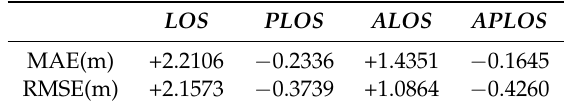
Table 5. MAE and RMSE fluctuations relative to u = 1.5